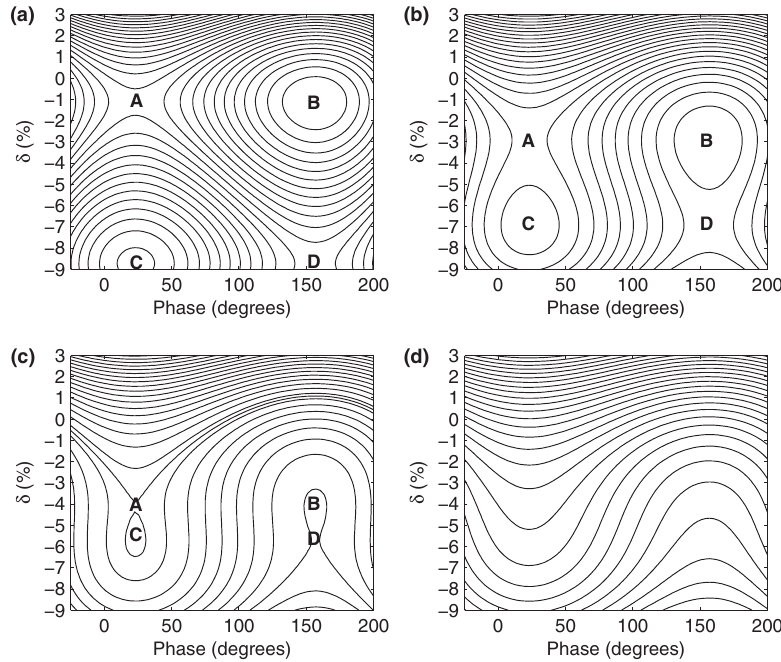
FIG. 2. Effect of the (cid:6) parameter on the longitudinal phase space for the SOLEIL nominal optics with (cid:1) 1 ¼ 4 : 38 (cid:1) 10 (cid:2) 4 , (cid:1) 2 ¼ 0 , and (cid:6) ¼ 4 : 3 (cid:1) 10 (cid:2) 9 in (a), (cid:6) ¼ 9 (cid:1) 10 (cid:2) 6 in (b), (cid:6) ¼ 1 : 05 (cid:1) 10 (cid:2) 5 in (c), and (cid:6) ¼ 1 : 3 (cid:1) 10 (cid:2) 5 in (d). 4 : 45 (cid:1) 10 (cid:2) 3 assuming (cid:1) 3 ¼ The fixed points B and D are located at phase (cid:2) s , while the points A and C are located at phase (cid:9) (cid:2) (cid:2) s . The on-momentum bucket is progressively off-centered while (cid:6) increases (see Table II for numerical values of the stable fixed points).